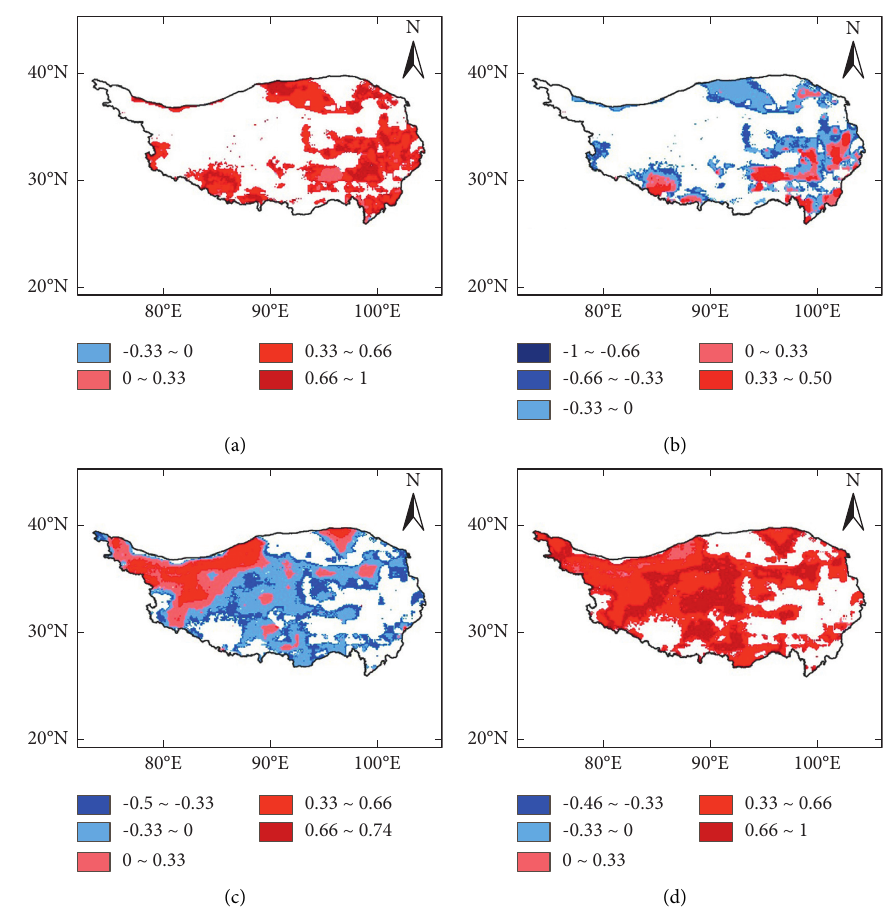
Figure 6: The respective contribution rate of the precipitation and temperature variability to the SPEI trend in the QTP. (a) and (b) are the contribution rates of the precipitation and temperature variability in the regions tending to be drier, and (c) and (d) are the contribution rates in the regions tending to be wetter. (a) Cr _temperature. (b) Cr _precipitation. (c) Cr _temperature. (d) Cr